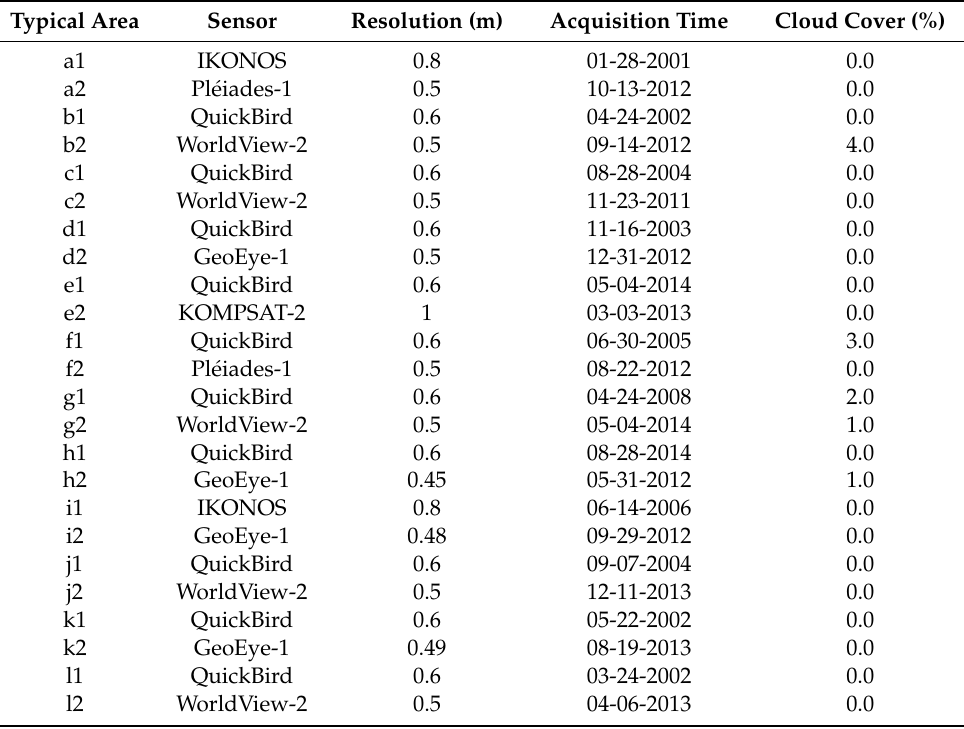
Table 1. Parameters of high-resolution satellite